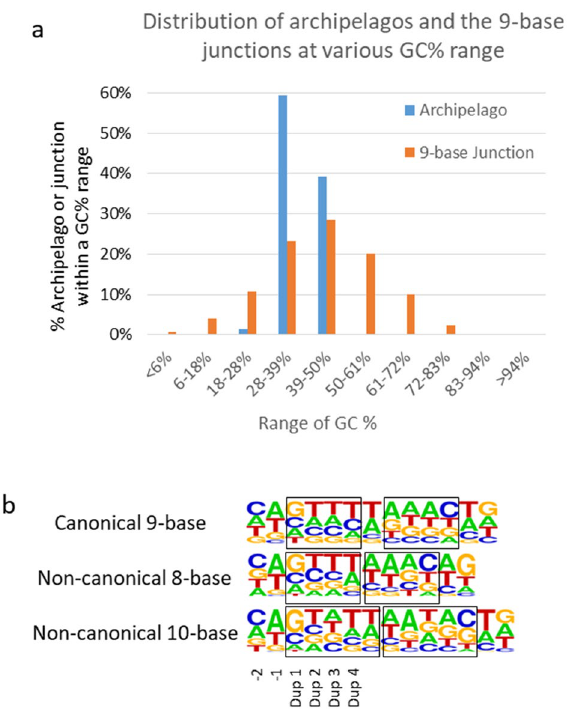
Figure 2. GC% of Archipelagos and the junction regions and base preference in the region at the transpososome cutting site. ( a ) GC distribution of Archipelago (blue) and GC distribution of the 9-base junction, at various range of GC%. ( b ) Base preference at 6 positions of top strand surrounding the cutting site for 9-base canonical and 8- and 10-base uncanonical cuts presented by sequence logo. The symmetry of the cutting site is marked by the two boxes. The six bases on the top strand flanking the cutting site in the direction from outside to the inside of the left monomer of the transposase are numbered as: -2,-1, Dup1, Dup2, Dup3 and Dup4, where the cut was made between -1 and Dup1. The graphs were generated by Microsoft Excel, Microsoft PowerPoint and weblogo (https:// weblo go. berke ley. edu/ logo.